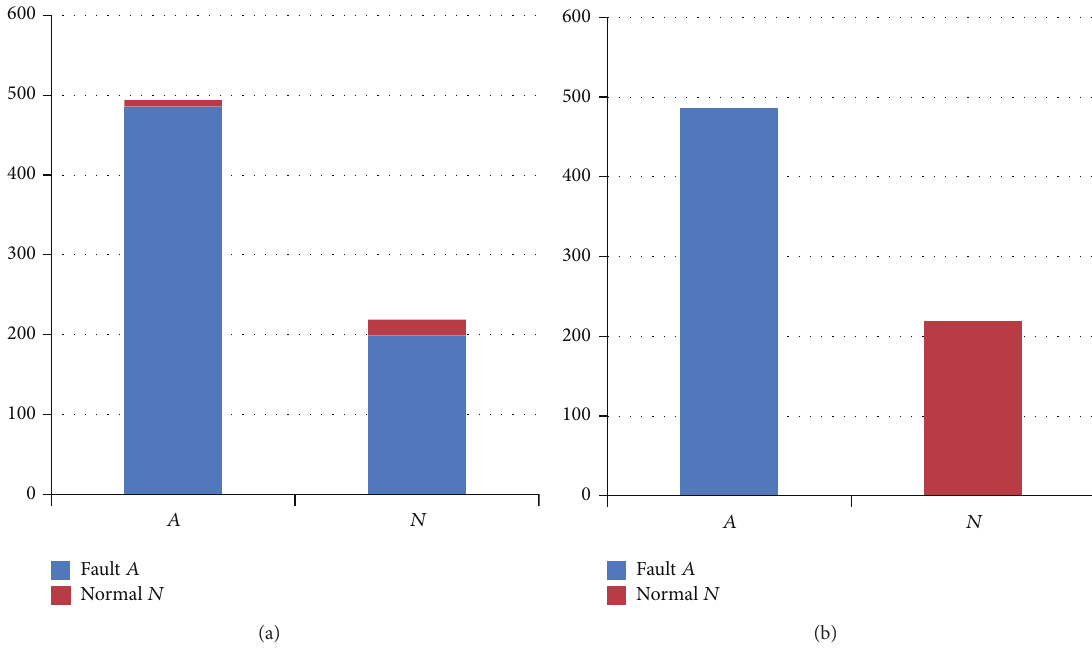
Figure 7: (a) The fault diagnosis results not considering the related parameters. (b) The ideal results with 100%